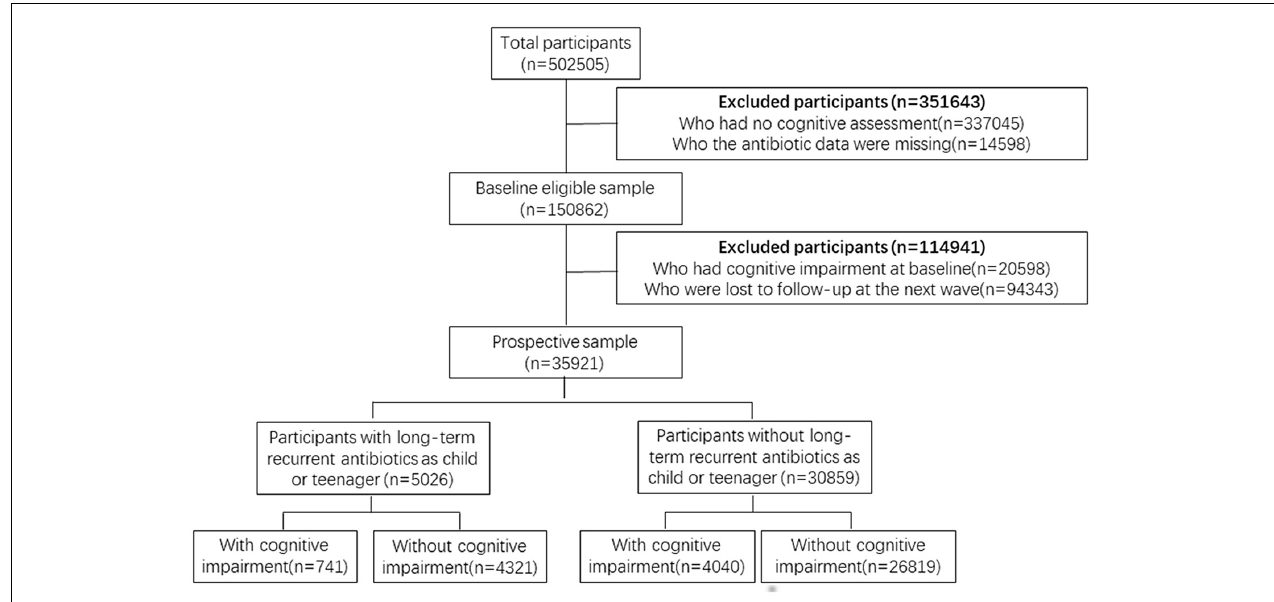
FIGURE 1 | Flow chart of participant inclusion and grouping.